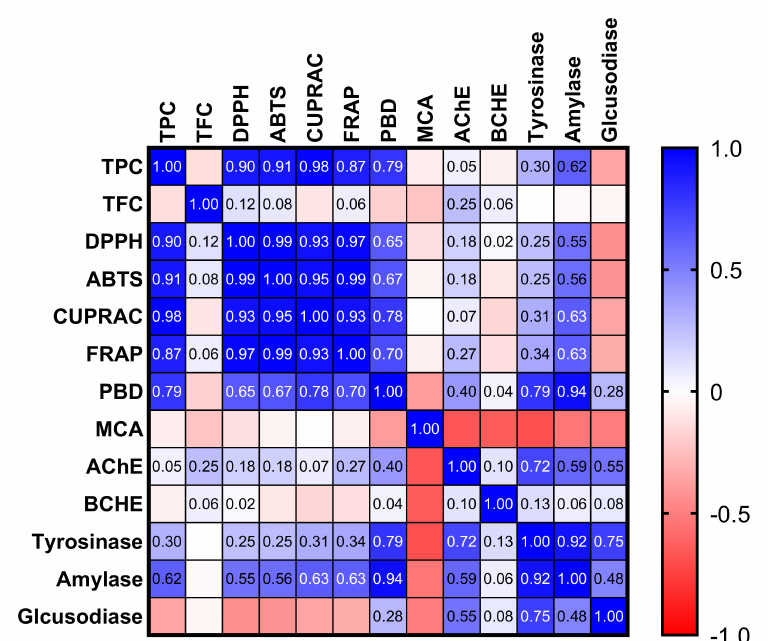
Figure 2. Pearson correlation values between biological activity assays ( p < 0.05): TPC, total phenolic content; TFC, total flavonoid content; ABTS, 2,2 (cid:48) -azino-bis(3-ethylbenzothiazoline)-6-sulphonic acid; DPPH, 1,1-diphenyl-2-picrylhydrazyl; CUPRAC, cupric reducing antioxidant capacity; FRAP, ferric reducing antioxidant power; AChE, acetylcholinesterase; BChE, butyrylcholinesterase; MCA, metal chelating ability; PBD,